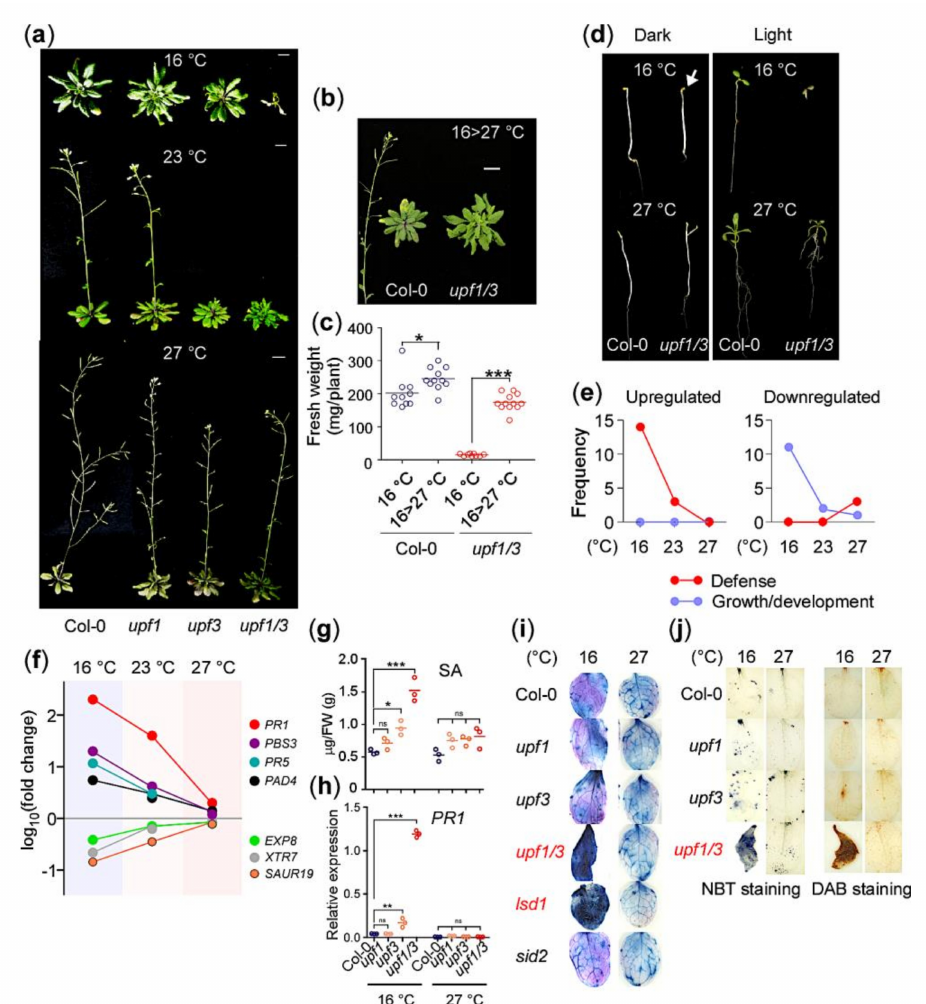
Figure 1. NMD (nonsense-mediated mRNA decay)-deficient upf1 / 3 mutants show growth arrest at 16 ◦ C ( a ) Phenotypes of upf mutants grown at 16 ◦ C, 23 ◦ C, and 27 ◦ C in soil (scale bar = 1 cm). ( b , c ) Growth phenotypes ( b ) and fresh weight ( c ) of upf1 / 3 mutants shifted from 16 ◦ C to 27 ◦ C. The photographs were taken 2 weeks after the temperature shift. ( d ) Phenotypes of upf1 / 3 mutants grown with or without light (long days, 16:8 h light:dark) at 16 ◦ C and 27 ◦ C. ( e ) Gradual increase in the number of defense-related GO terms among upregulated genes and growth / development-related GO terms among downregulated genes in upf1 / 3 mutants at lower temperatures. ( f ) Expression levels of marker genes of defense and growth / development in upf1 / 3 mutants at 16 ◦ C, 23 ◦ C, and 27 ◦ C. The expression levels are represented as log fold-change values from RNA-seq data. ( g ) Salicylic acid (SA) levels in upf1 / 3 mutants at 16 ◦ C and 27 ◦ C compared with wild type (Col-0) plants. ( h ) Transcript levels of PR1 in upf mutants at 16 ◦ C and 27 ◦ C. ( i ) Trypan blue staining of the leaves of upf mutants grown at 16 ◦ C and 27 ◦ C. Note that only leaves of upf1 / 3 and lsd1-2 mutants showed dark staining. SA-hyperaccumulating lsd1 mutants and SA biosynthesis-defective sid2 mutants were used as controls. ( j ) NBT (nitro blue tetrazolium) staining and DAB (3,3 (cid:48) -diaminobenzidine) staining assays using upf1 / 3 mutants at 16 ◦ C and 27 ◦ C. *: p < 0.05; **: p < 0.01; ***: p ≤ 0.001; ns: not significant